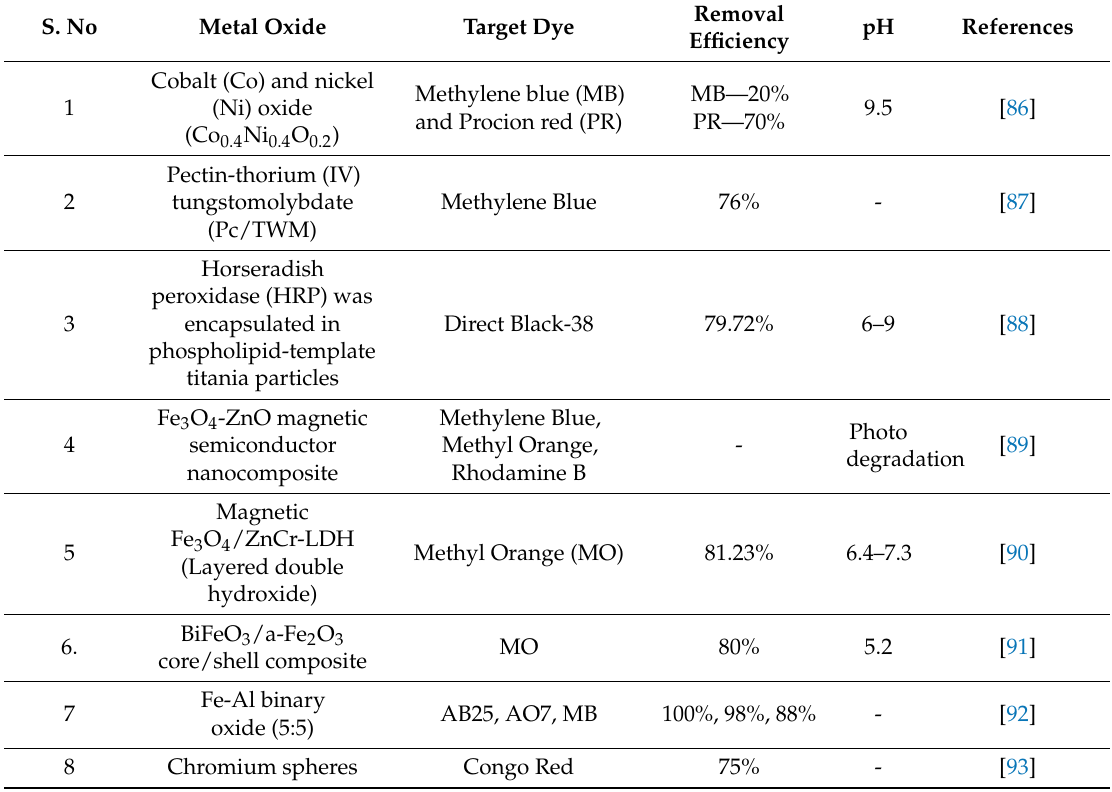
Table 2. Metal oxides in dye degradation and/or